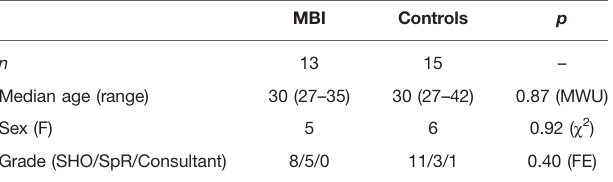
TABLE 1 | Demographic characteristics of participants.